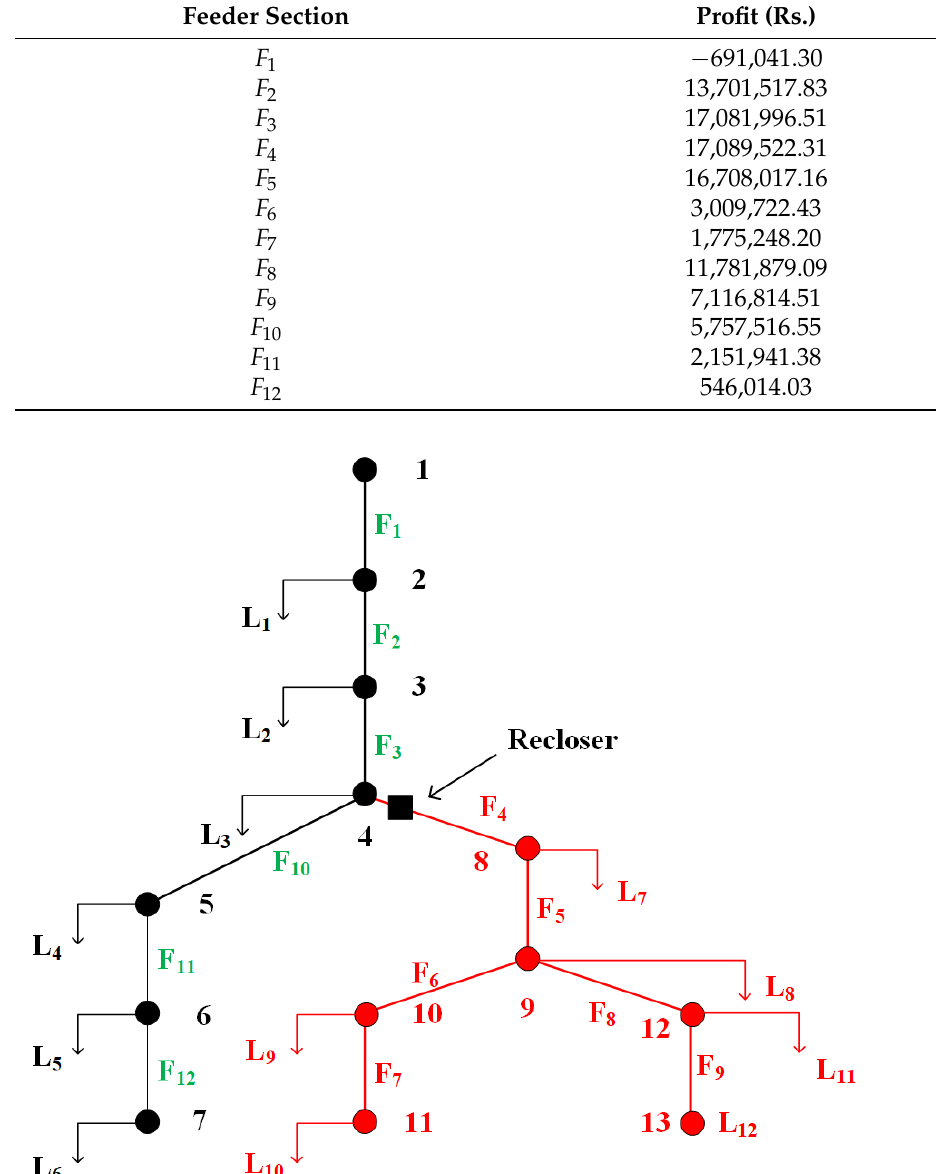
Table 3. Profit after a recloser placement in various feeder sections of the 13-bus RDS. Feeder Section